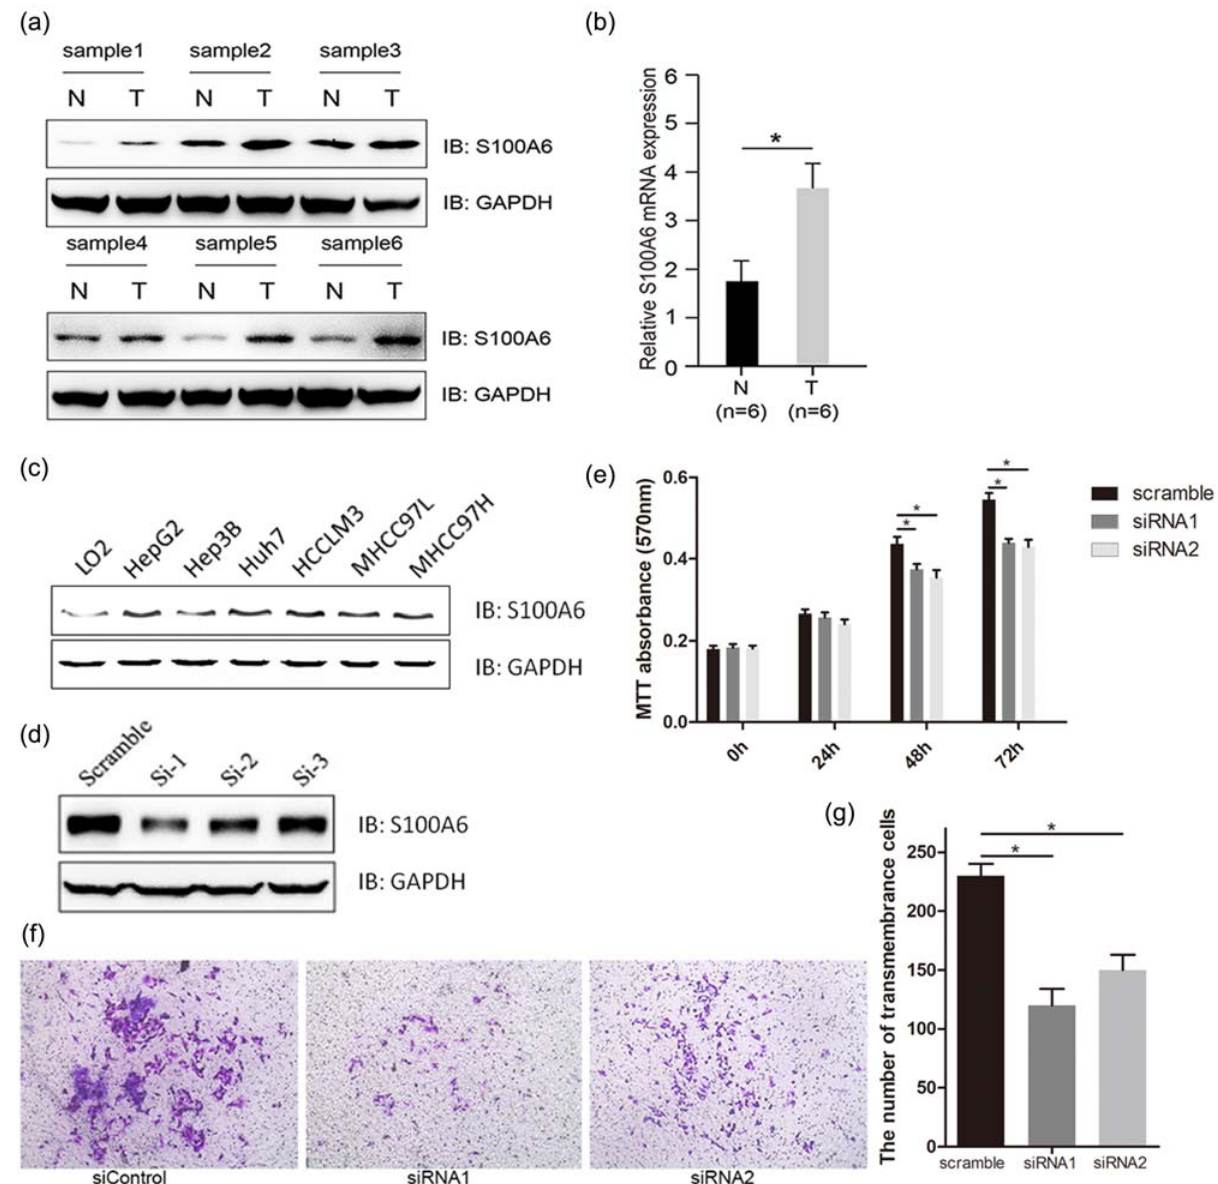
Figure 1: S100A6 expression levels in clinical HCC tissues and adjacent non - tumor tissues. ( a ) Immunoblotting shows the S100A6 protein levels in di ff erent pairs of clinical HCC tissues. ( b ) Detection of mRNA levels of S100A6 in di ff erent pairs of clinical HCC; N: adjacent non - tumor tissue; T: HCC tissues. * P < 0.05. ( c ) Immunoblotting shows the S100A6 protein levels in di ff erent HCC cell lines and the normal liver cell line L02.